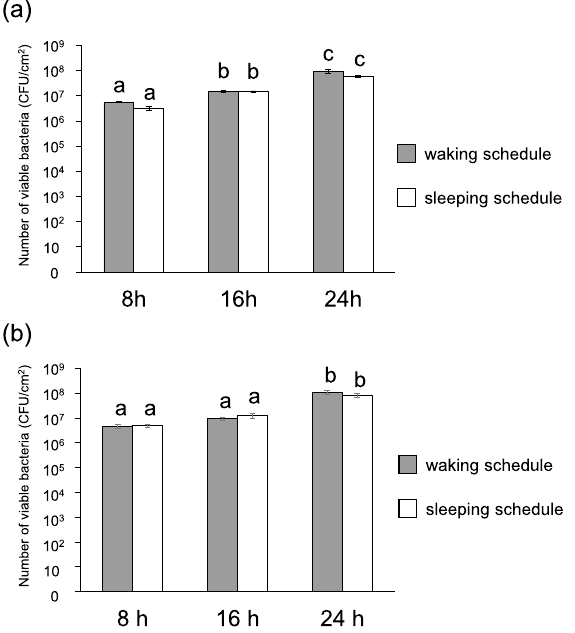
Figure 3. Numbers of viable biofilm-forming bacteria. ( a , b ) Numbers of viable biofilm-forming bacteria over time in dental biofilms from the waking and sleeping schedules, grown under aerobic ( a ) or anaerobic ( b ) conditions, as measured by counting colonies. Significant differences are represented by different letters (Friedman’s test at p <